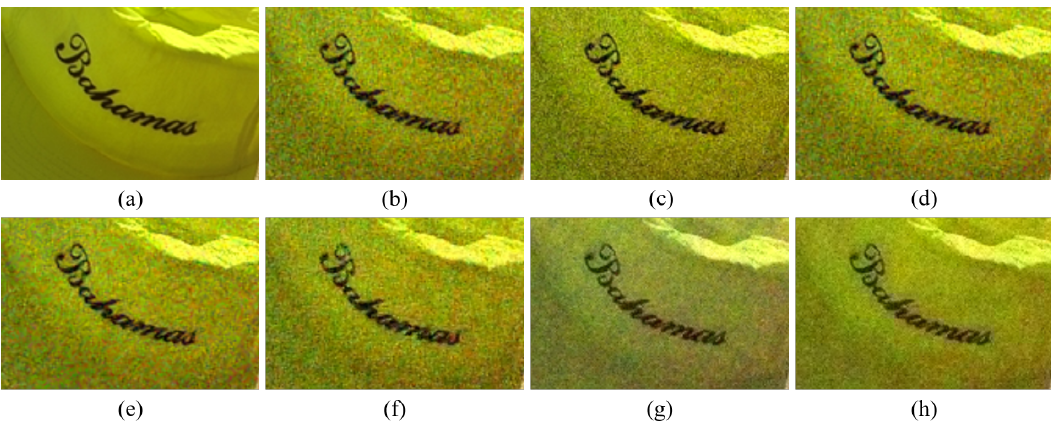
Figure 13. Showing the enlarged regions of Figure 12. ( a ) Original ( b ) ICC [12], ( c ) DNet [13] ( d ) RI [14]